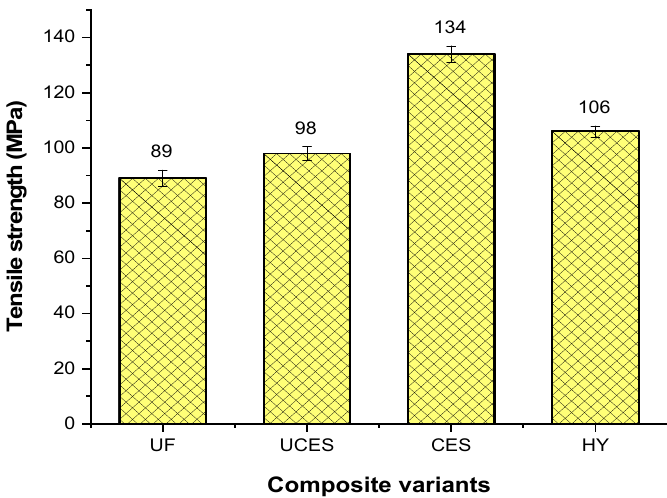
Figure 4. Tensile strength comparison of composite variants.